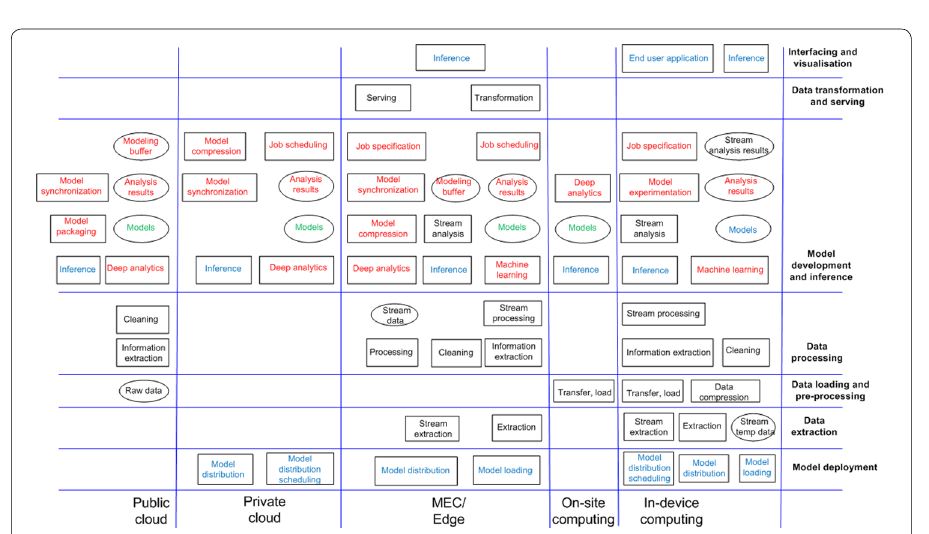
Fig. 25 Architectural elements of the deployment environment view of the big data RA associated with model development (red) and model deployment (blue). Green indicates association to model development and